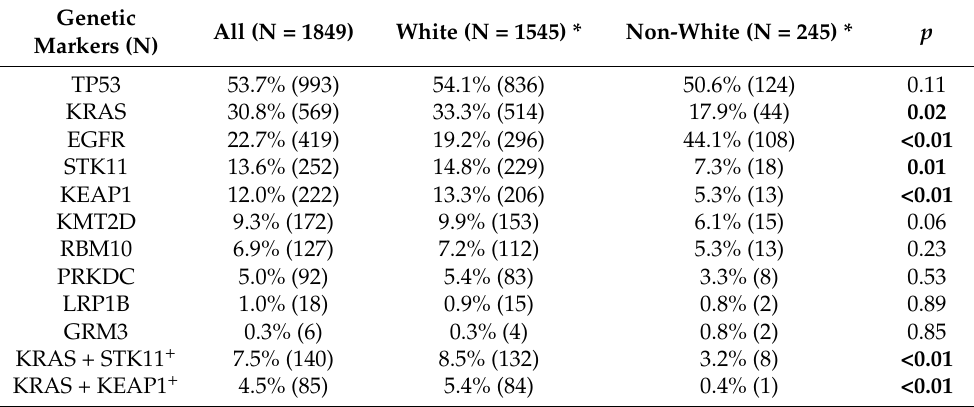
Table 3. Genetic marker distribution globally and by